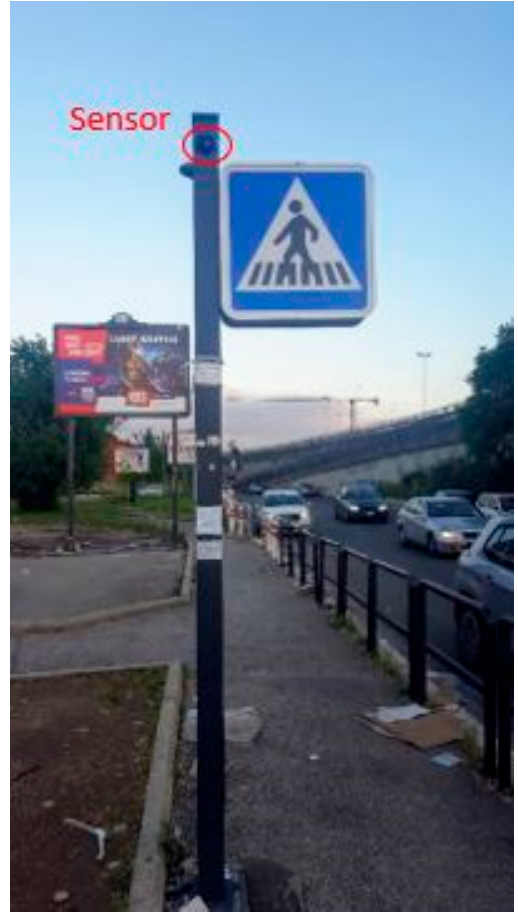
Figure 4. Optical sensor.